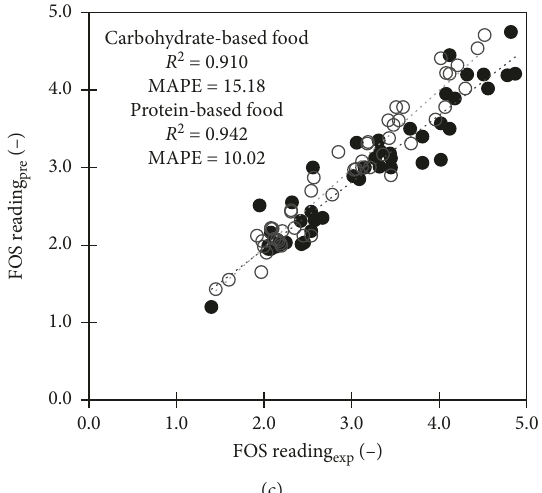
Figure 8: Validation of prediction models for (a) FFA, (b) TPMs, and (c) FOS reading based on the contact angle obtained from